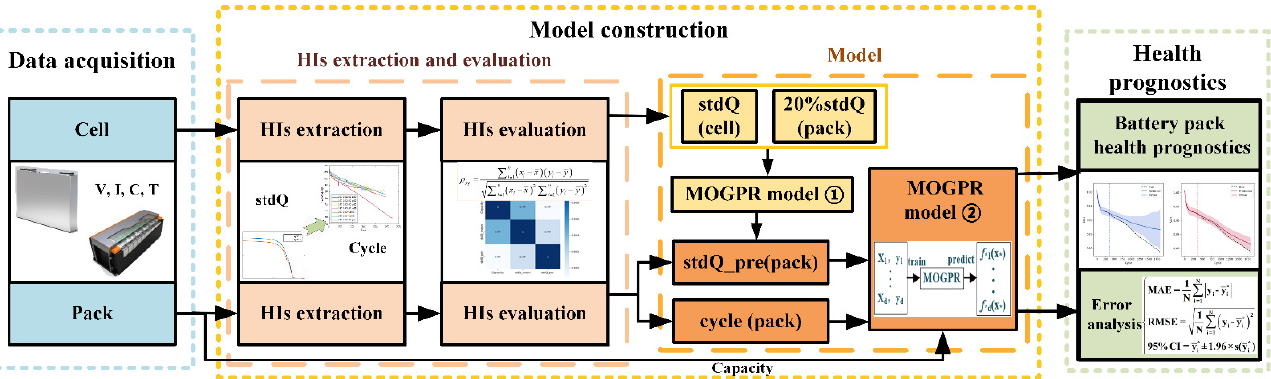
Figure 1. The composition and implementation principle of the battery SOH prediction method.